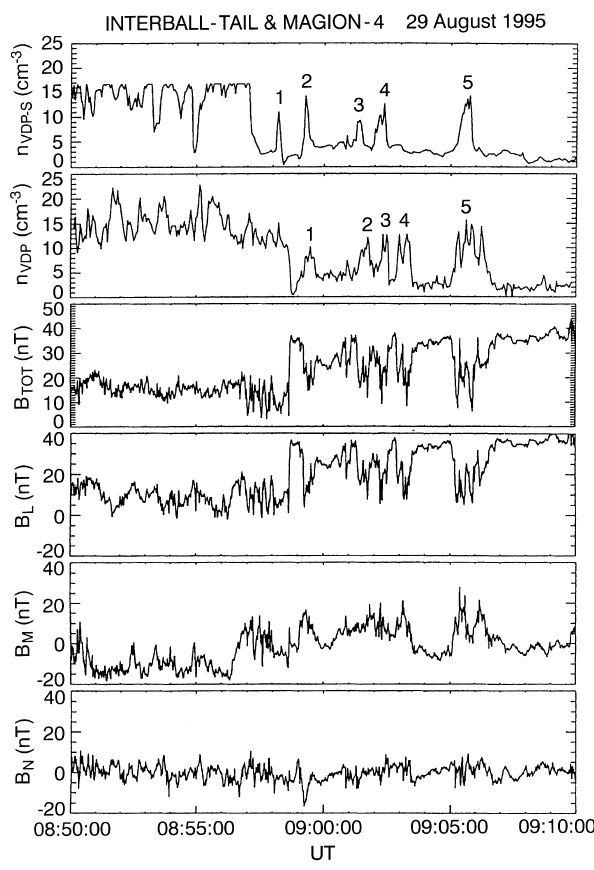
Fig. 6. Plasma and magnetic-field measurements on a pass from the magnetosheath into the magnetosphere ( from top to botom : ion density measured by the MAGION-4, ion density field provided by the INTERBALL-1, INTERBALL-1 magnetic field magnitude and three components of the magnetic field in the boundary normal coordinates.